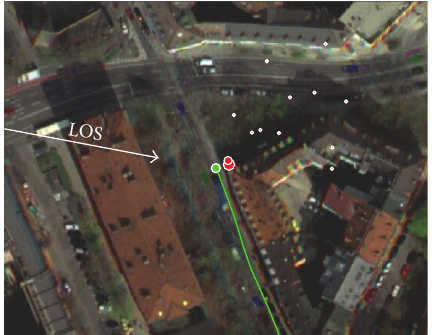
Figure 11: Snapshot from the car measurement in the center of Munich, showing the power of the present echoes at the estimated reflector